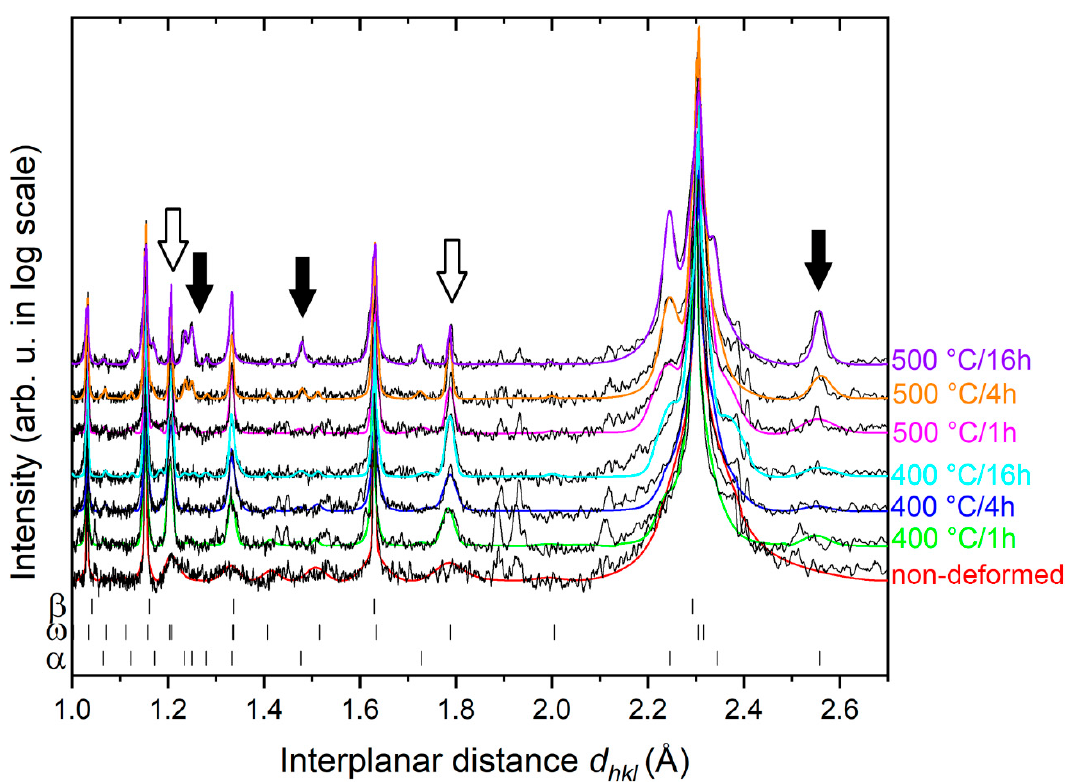
Figure 6. X-ray diffraction (XRD) patterns (in log-scale) of aged conditions of the non-deformed Ti15Mo alloy. Black thin curves correspond to data, colored curves are numerical fits. Non-deformed without ageing (red curve) and aged conditions (other colored curves) are displayed. The patterns are vertically shifted for clarity. The most important peaks are marked by full and open arrows for α and ω phase, respectively. Two unfitted peaks around d hkl = 1.9 originated from the sample holder.